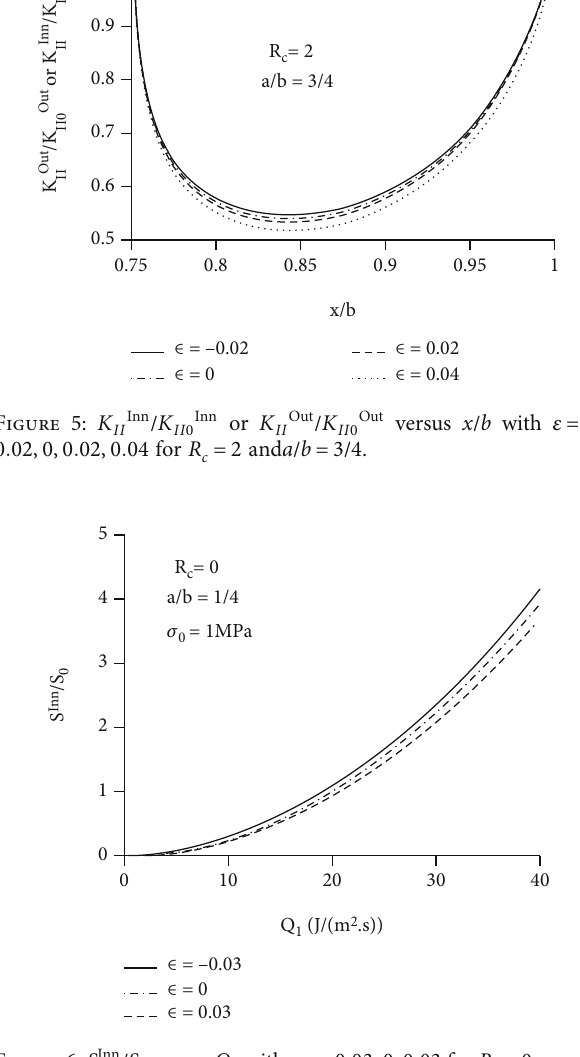
0 versus Q 1 with